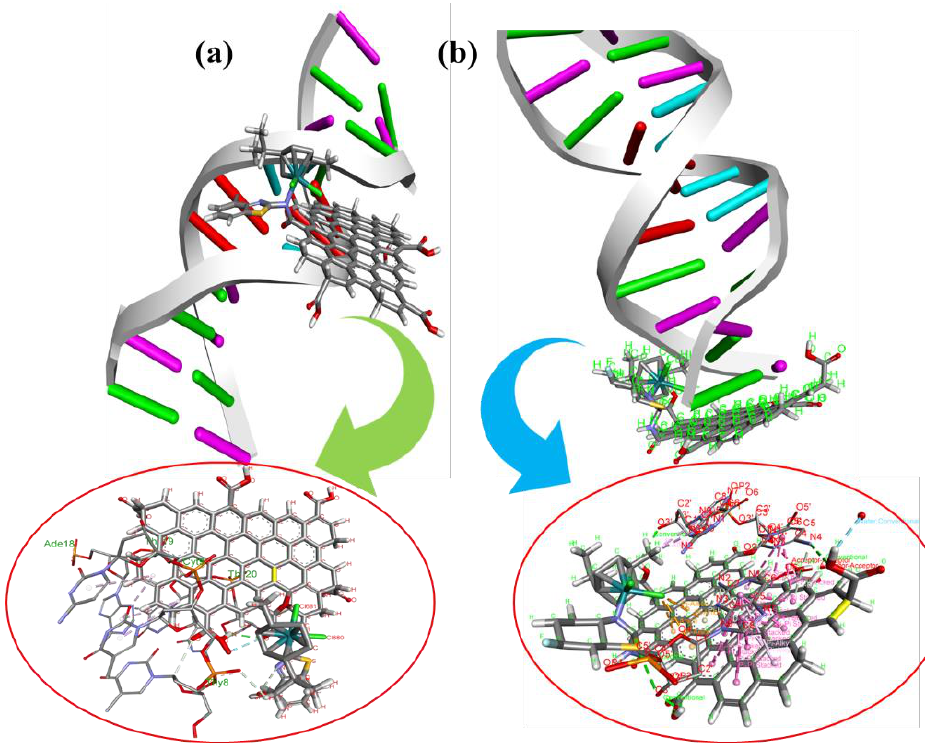
Figure 14. Docked pose of ( a ) GO-NCD- 1 and ( b ) GO-NCD- 2